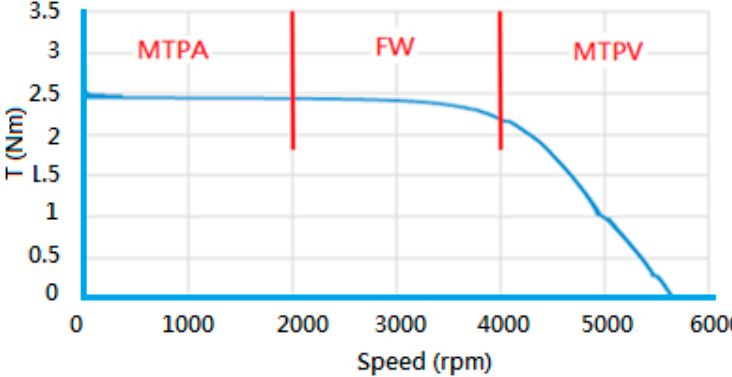
Figure 19. T-N Curve by MTPA and FW and MTPV control with load of 2.5 Nm in the whole Figure 17. T-N Curve by MTPA and FW and MTPV control with load of 2.5 Nm in the whole speed speed range.